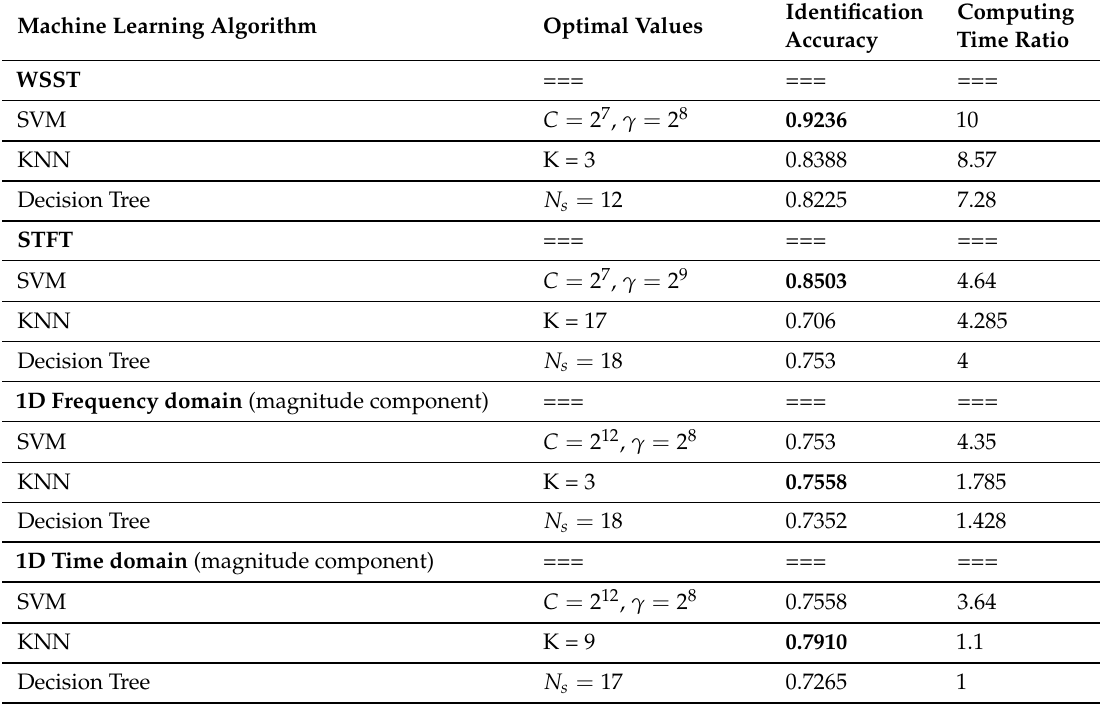
Table 2. Optimal values for the hyperparameters of the machine learning algorithms with the related identification accuracy and computing time